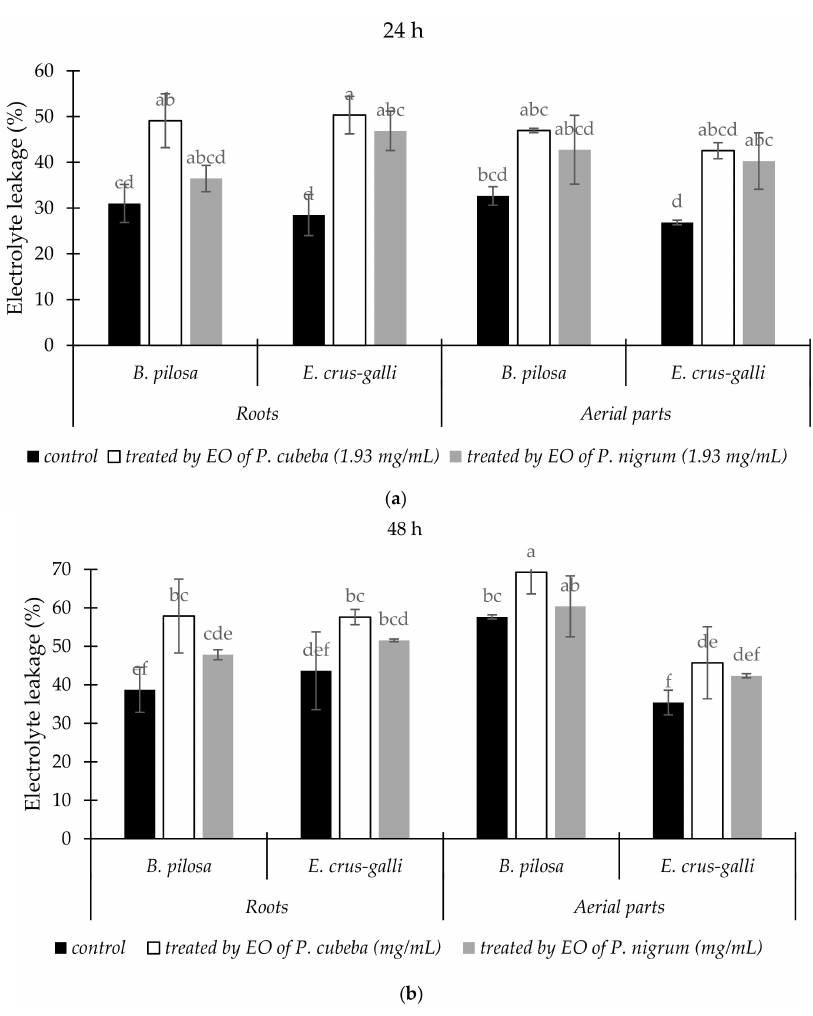
Figure 2. The changes of electrolyte leakage (%) of B. pilosa and E. crus-galli between control and treatments after 24 h ( a ) and 48 h ( b ). Data were presented in means ± standard deviations (SD). Means with di ff erent small letter indicted significantly di ff erent by Fisher’s test ( p <